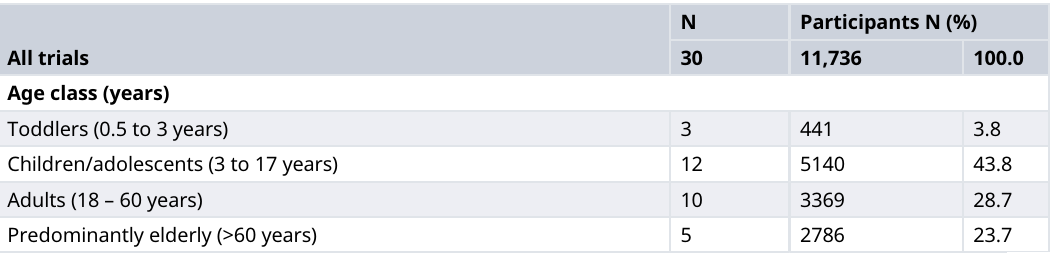
Table 1. Population characteristics of 30 clinical trials included in the